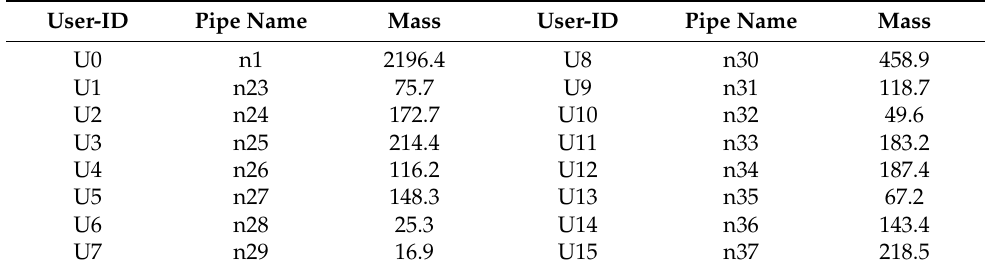
Table 1. Heat source and user flow design